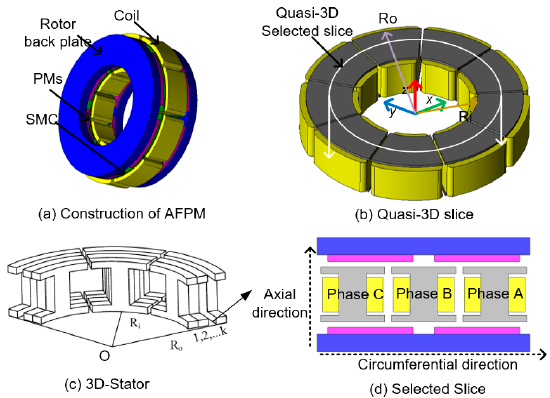
Figure 1. Construction of the investigated axial flux permanent magnet machine (AFPMM) ( a ) and the principle of quasi-3D method ( b – d ). Table 1. Parameters of the 6-Pole, 9-Slot axial flux permanent magnet machine (AFPMM). SMC: Soft magnetic composite; PM: Permanent magnet.